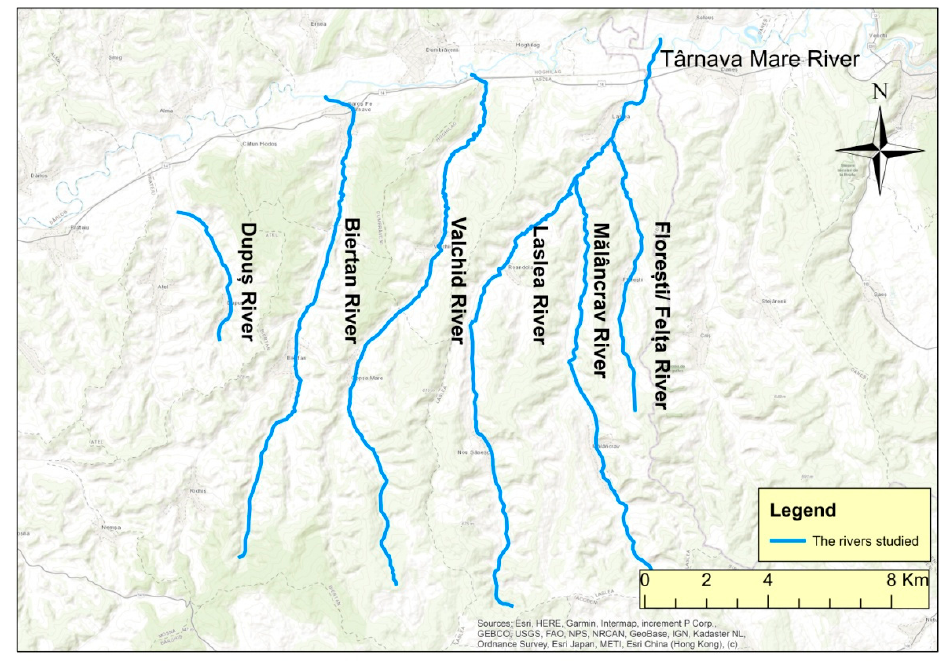
Figure 2. The studied lotic systems.